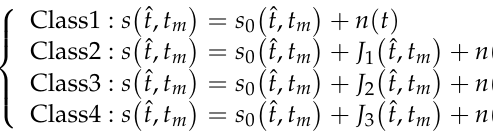
Figure 3. The aircraft scattering point target.